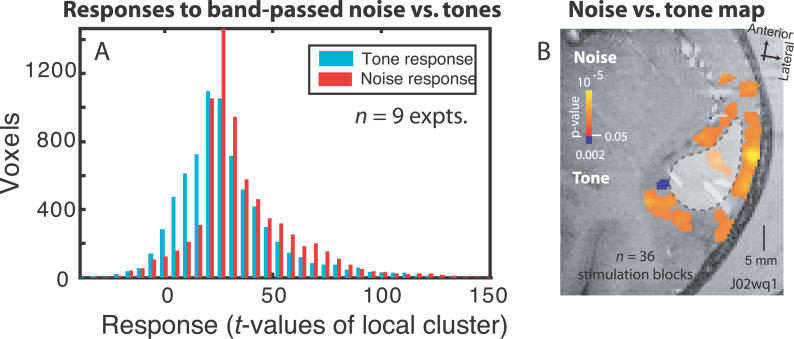
Comparing Noise to Tone Responses Reveals a Preference for Noise in the BeltIn nine experiments we individually presented single frequency tones within the range of the comparison band-passed noise (see “Sound stimuli and presentation” in
Materials and Methods) and compared responses. (A) Shows distributions of the auditory cortex response (see “MRI data analysis” in
Materials and Methods) to tone or noise stimulation. The analysis is based on voxels significantly active to at least one of the stimulation conditions, i.e., under tone or noise stimulation. Voxels responded more to noise than tones (Wilcoxon rank sum test of the distributions,
p < 0.0001). (B) Noise responses were larger than tone responses in regions of the auditory belt, as illustrated by this example experiment, confirming and extending predictions from neurophysiological recordings of the lateral belt [
19,
21].